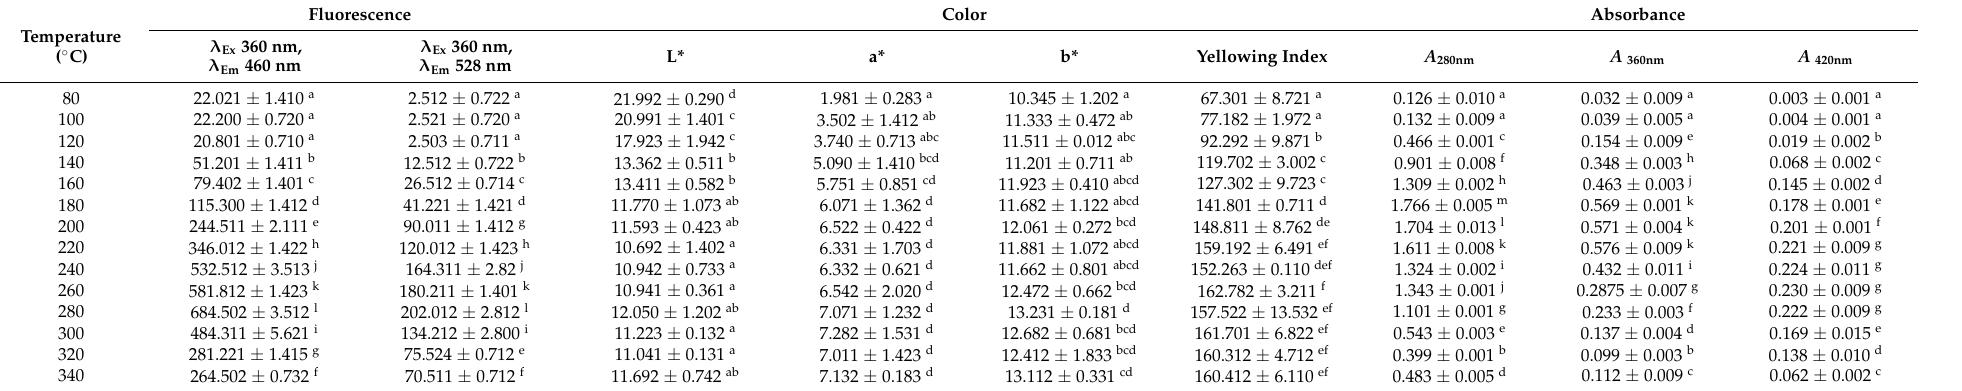
Table 1. The fluorescence, color, and absorbance of licorice extracts obtained at different